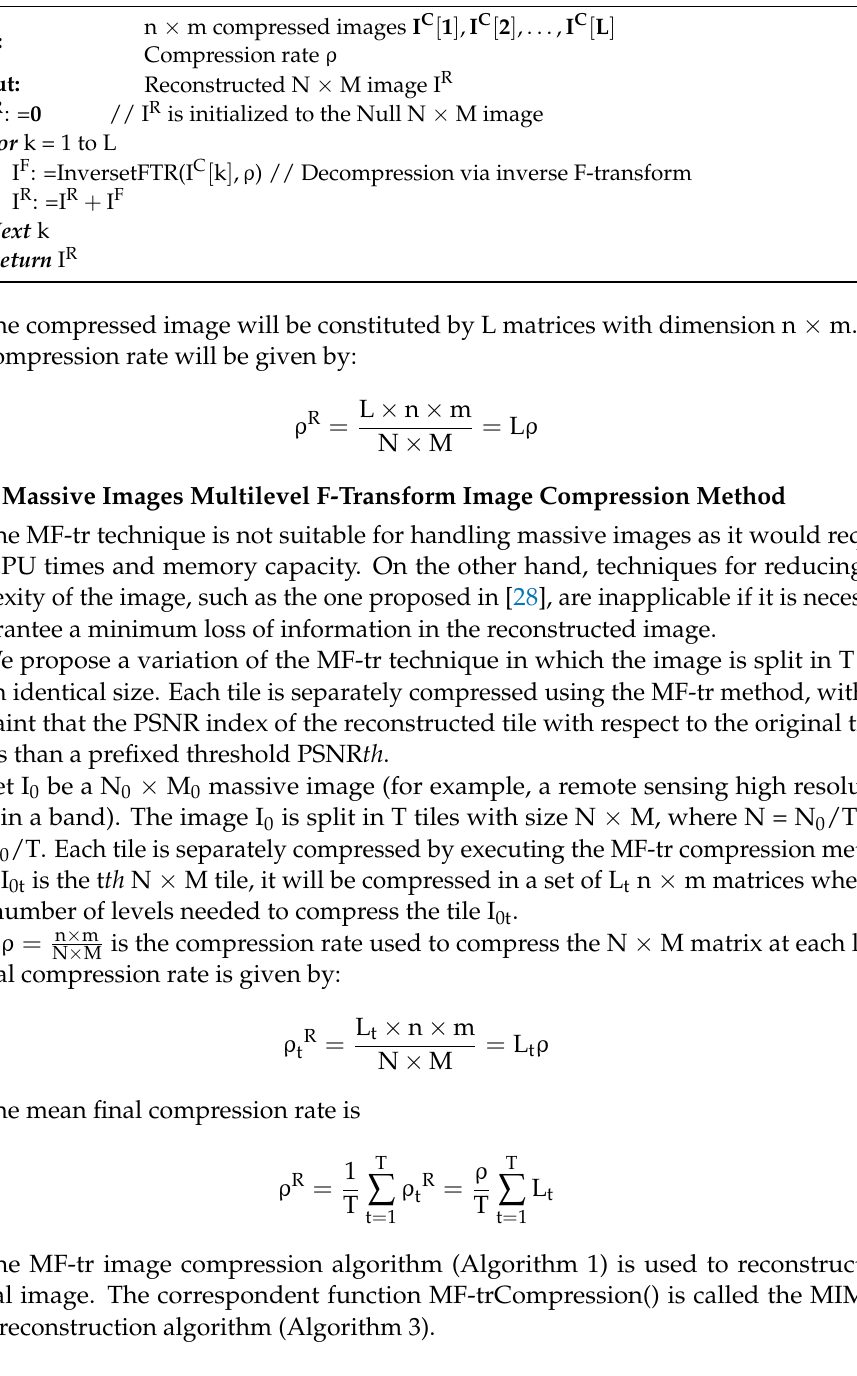
Algorithm 2 MF-tr image